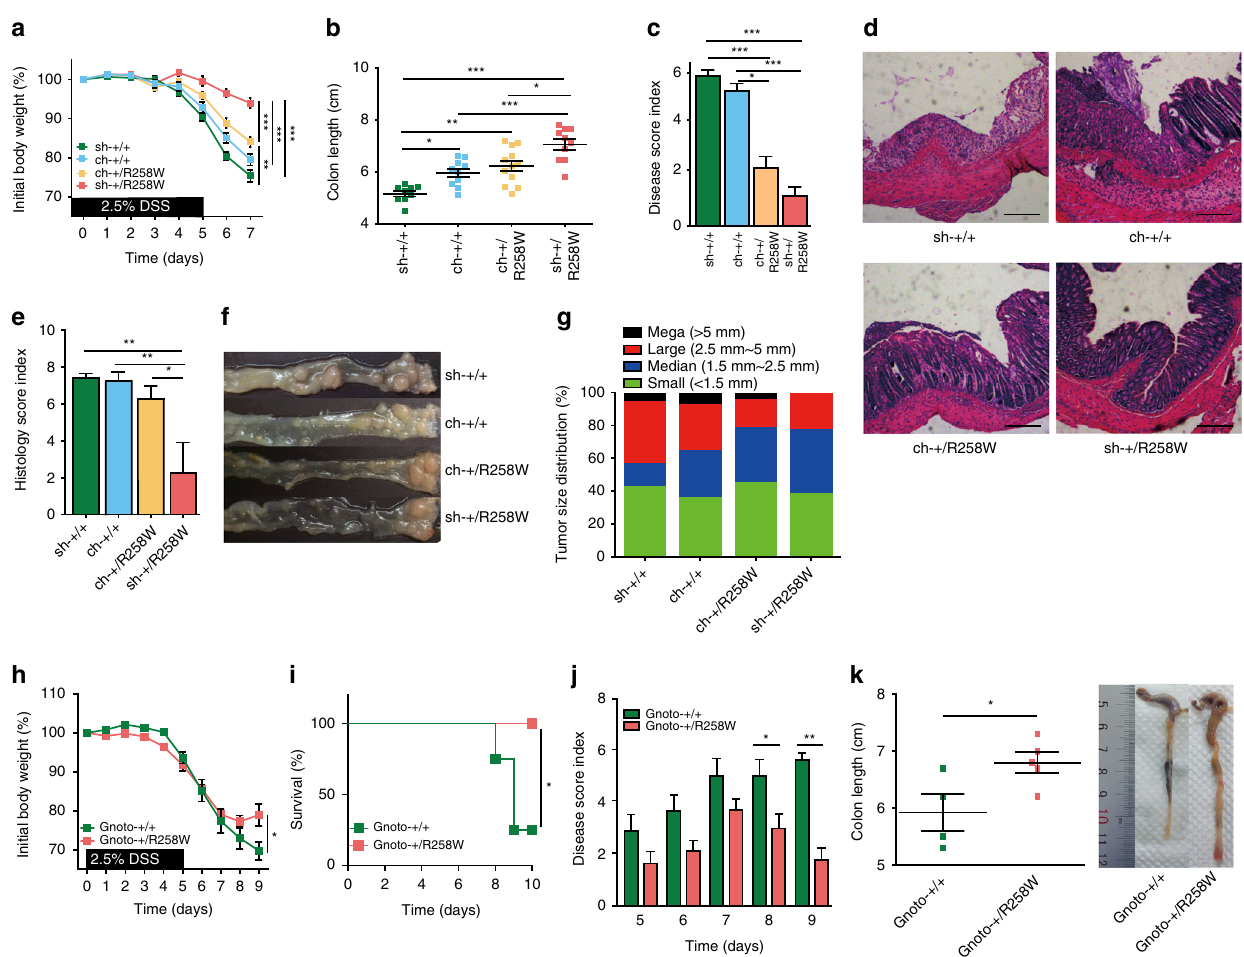
Fig. 5 The gut microbiota of Nlrp3 R258W mice confers resistance to DSS-induced colitis and colorectal cancer. a – e Acute colitis was induced in sh-+/+ ( n = 13) and sh-+/R258W ( n = 10) mice and 1:1 cohoused (ch-, n = 12 for each genotype) mice. The analyses of body weights ( a ), colon length ( b ), disease scores ( c ), histological examination ( d ), scale bar is 200 μ m, and histological score ( e ) were conducted as described in Fig. 2, except that the mice were killed on day 7. The data in a , b , c and e are shown as the means ± SEM. * P < 0.05, ** P < 0.01, *** P < 0.001 (one-way ANOVA with Tukey ’ s post-hoc test). f , g Colon cancer was induced and monitored in singly housed and cohoused mice ( n = 6 for each group), the representative colon tumor ( f ) and total tumor size distribution ( g ) were shown. h – k Feces from the WT and Nlrp3 R258W mice were transplanted to germ-free WT mice (Gnoto-+/+, n = 4, Gnoto- +/R258W, n = 5), and acute colitis was then induced with 2.5% DSS. The diseases were assayed as described in Fig. 2, except that the mice were killed on day 9. The data in h , j and k are shown as the means ± SEM. * P < 0.05, ** P < 0.01 (two-tailed Student ’ s t test). Survival rate is shown in i , * P < 0.05